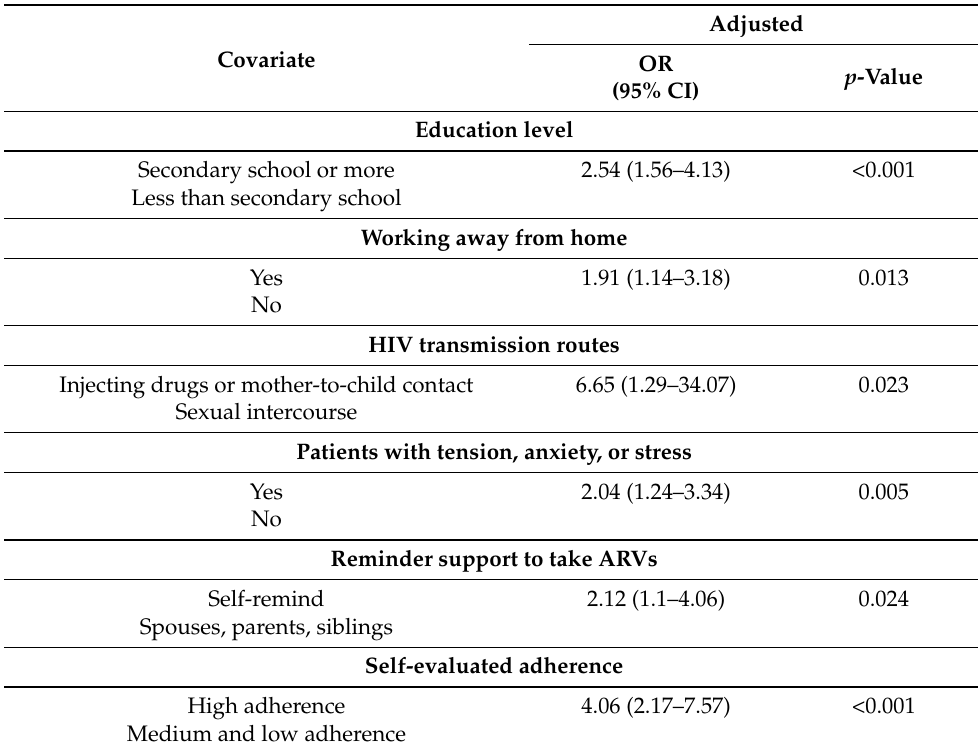
Table 3. Factors associated with knowledge regarding ARV